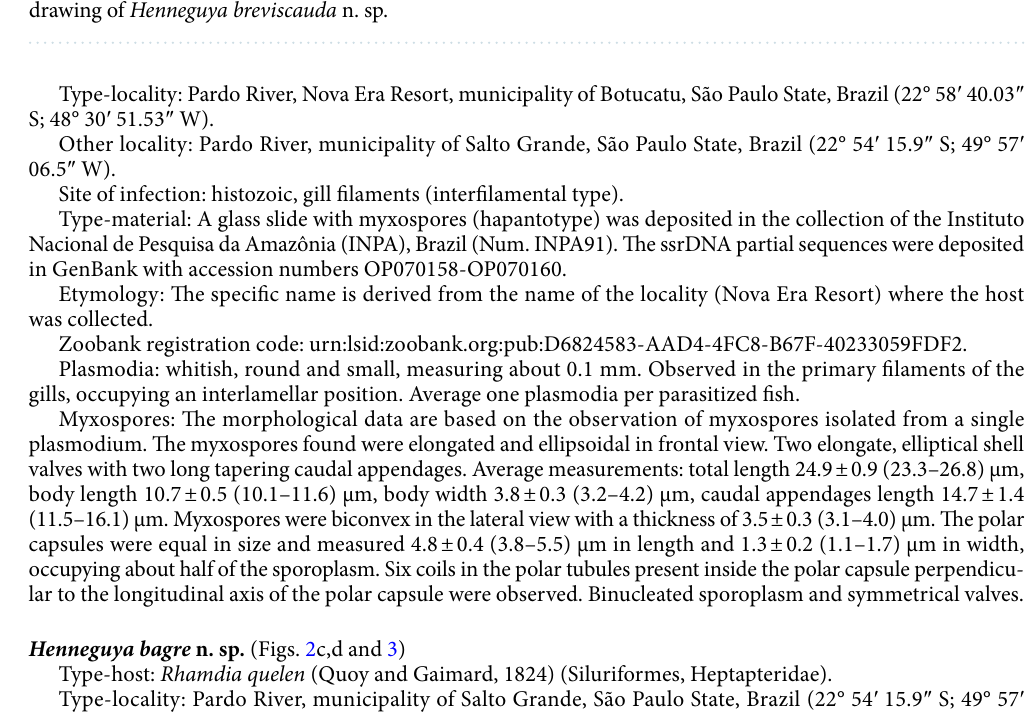
Figure 2. ( a ) –(f ) Line drawings of new Henneguya spp. ( a ) Front view drawing of Henneguya novaerae n. sp. ( b ) Side view drawing of Henneguya novaerae n. sp. ( c ) Front view drawing of Henneguya bagre n. sp. ( d ) Side view drawing of Henneguya bagre n. sp. ( e ) Front view drawing of Henneguya breviscauda n. sp. ( f ) Side view drawing of Henneguya breviscauda n.